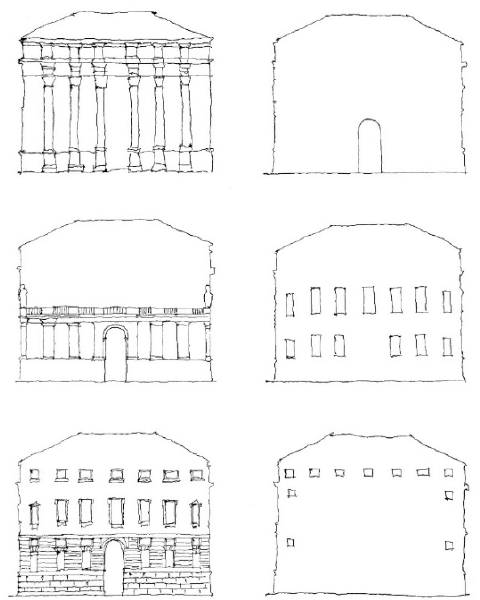
Figure 2. The rearranged layers of Palazzo Valmarana in Vicenza, Italy. The left column represents the relief layers, while the right represents the void layers. The layers in the same rows display the same scales ( n = 1 to 3), or the levels of magnification. The layers on the same levels may be united in order to calculate their combined Hausdorff dimension.